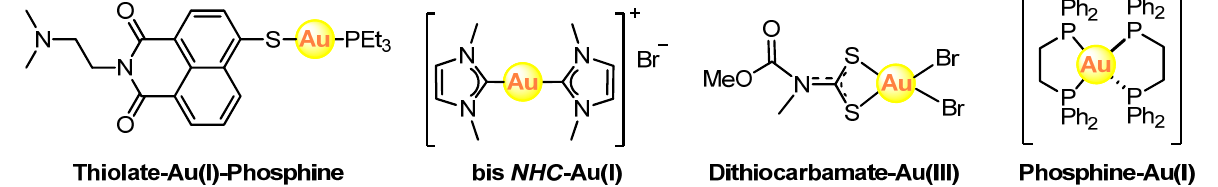
Figure 1. Biologically active gold complexes with interesting ligands.